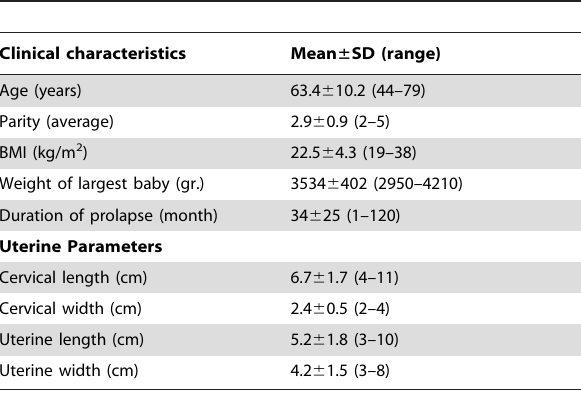
Table 1. Clinical and demographic characteristics for the study group.